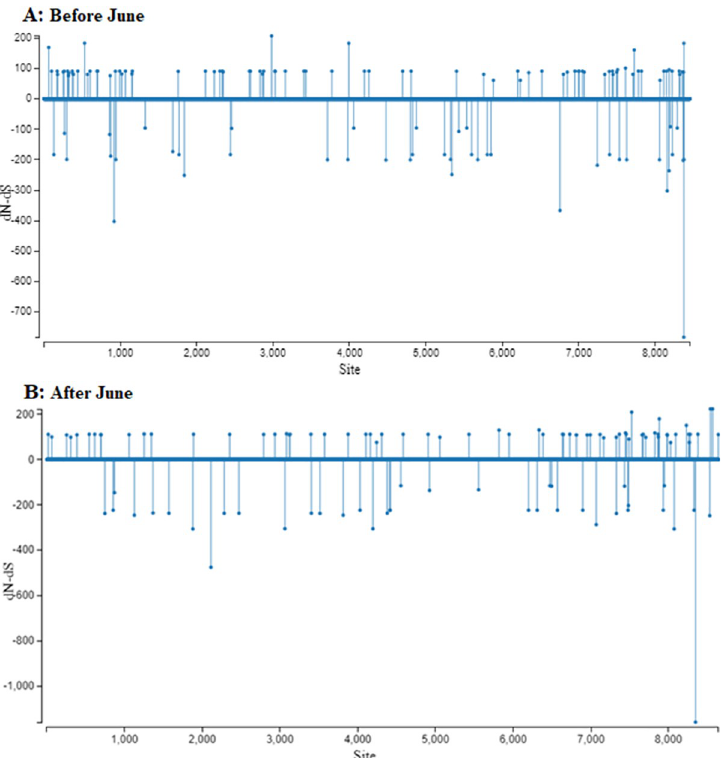
Fig 7. Genome-wide site-by-site selection pressure analysis for SARS-CoV-2 sequences from before and after June, 2020. Selection pressure (relative number of non-synonymous substitutions minus synonymous substitutions (dN–dS)) on each codon is shown for sequences A) before June 2020 and B) after June 2020.